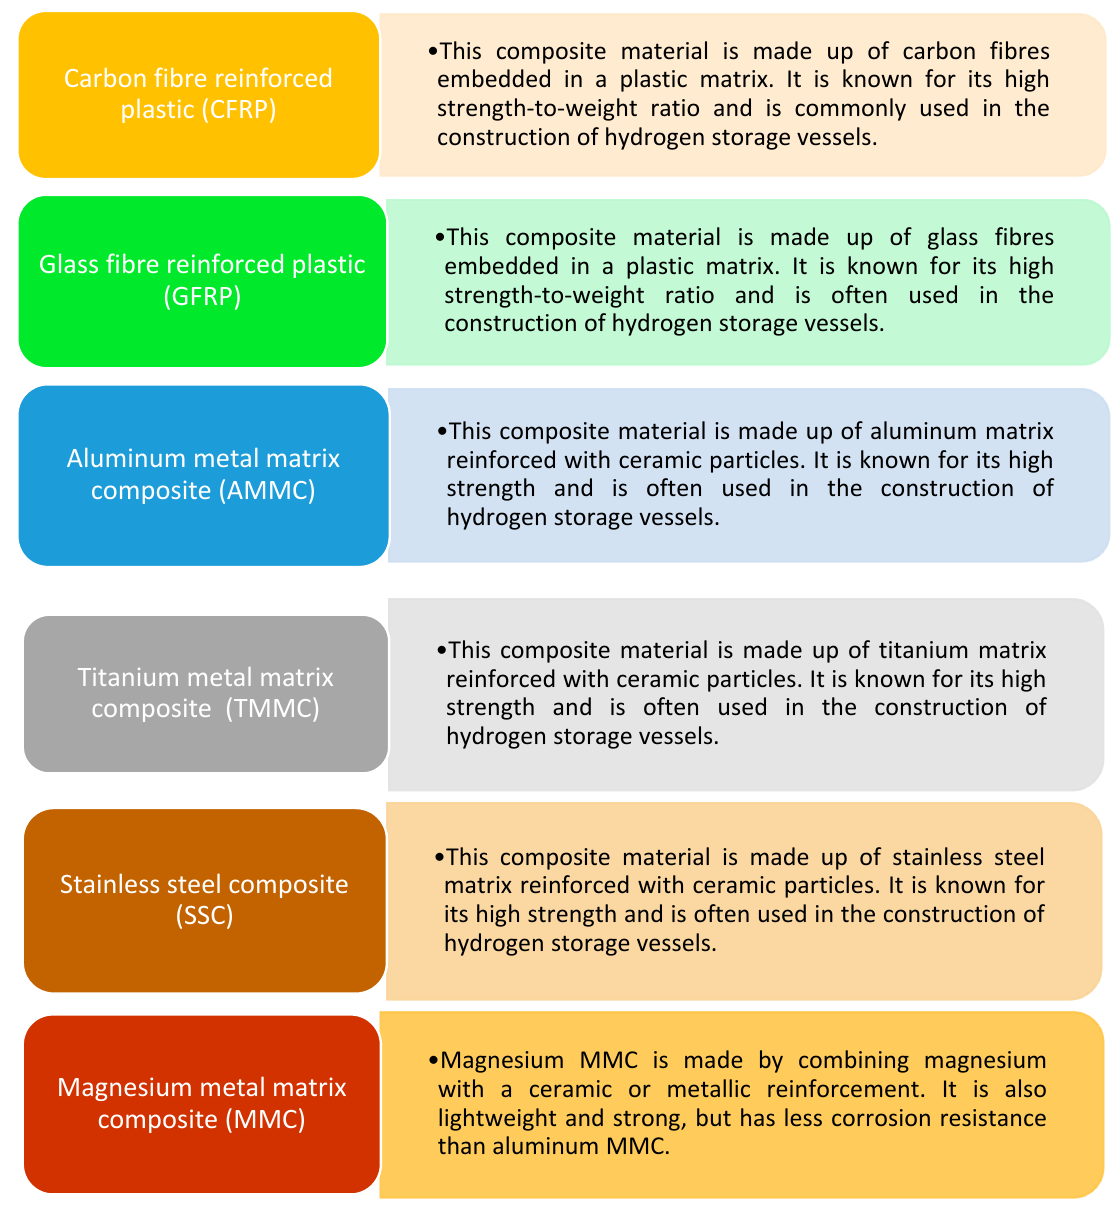
Figure 9. Composite materials for hydrogen storage.